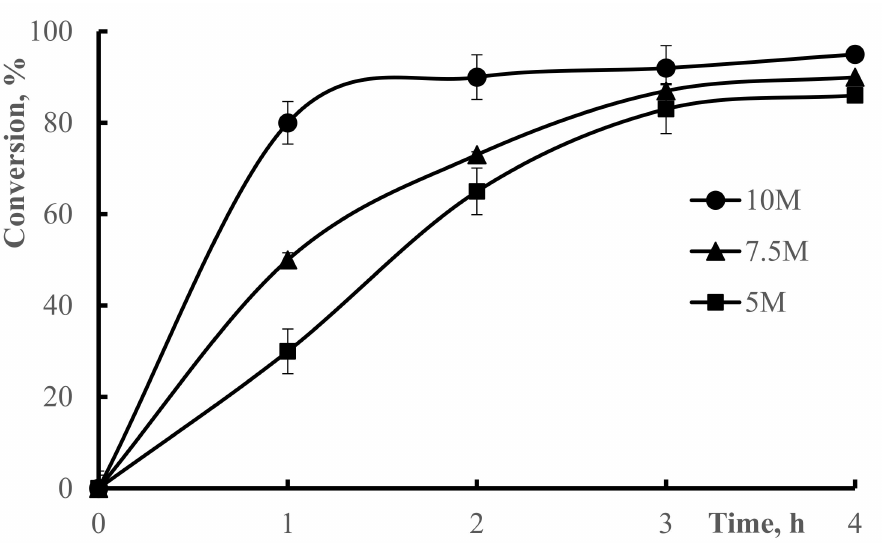
Figure 1. Conversion of 50–50% DMAA–AMPS hydrogel over time at various monomer concentra- tions. Conditions: initiator concentration 0.07% of total monomer mass, 0.74% crosslinker, reaction temperature 60 ◦